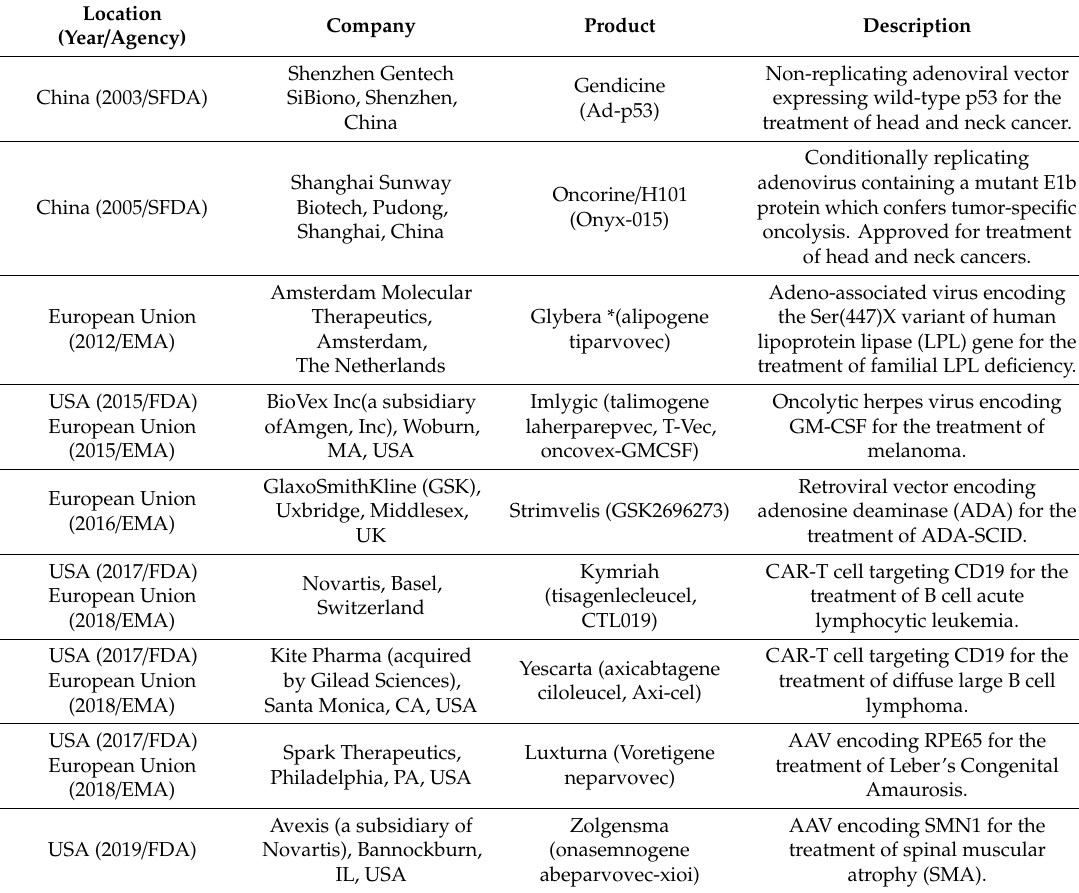
Table 1. Principal gene therapy products approved for commercial